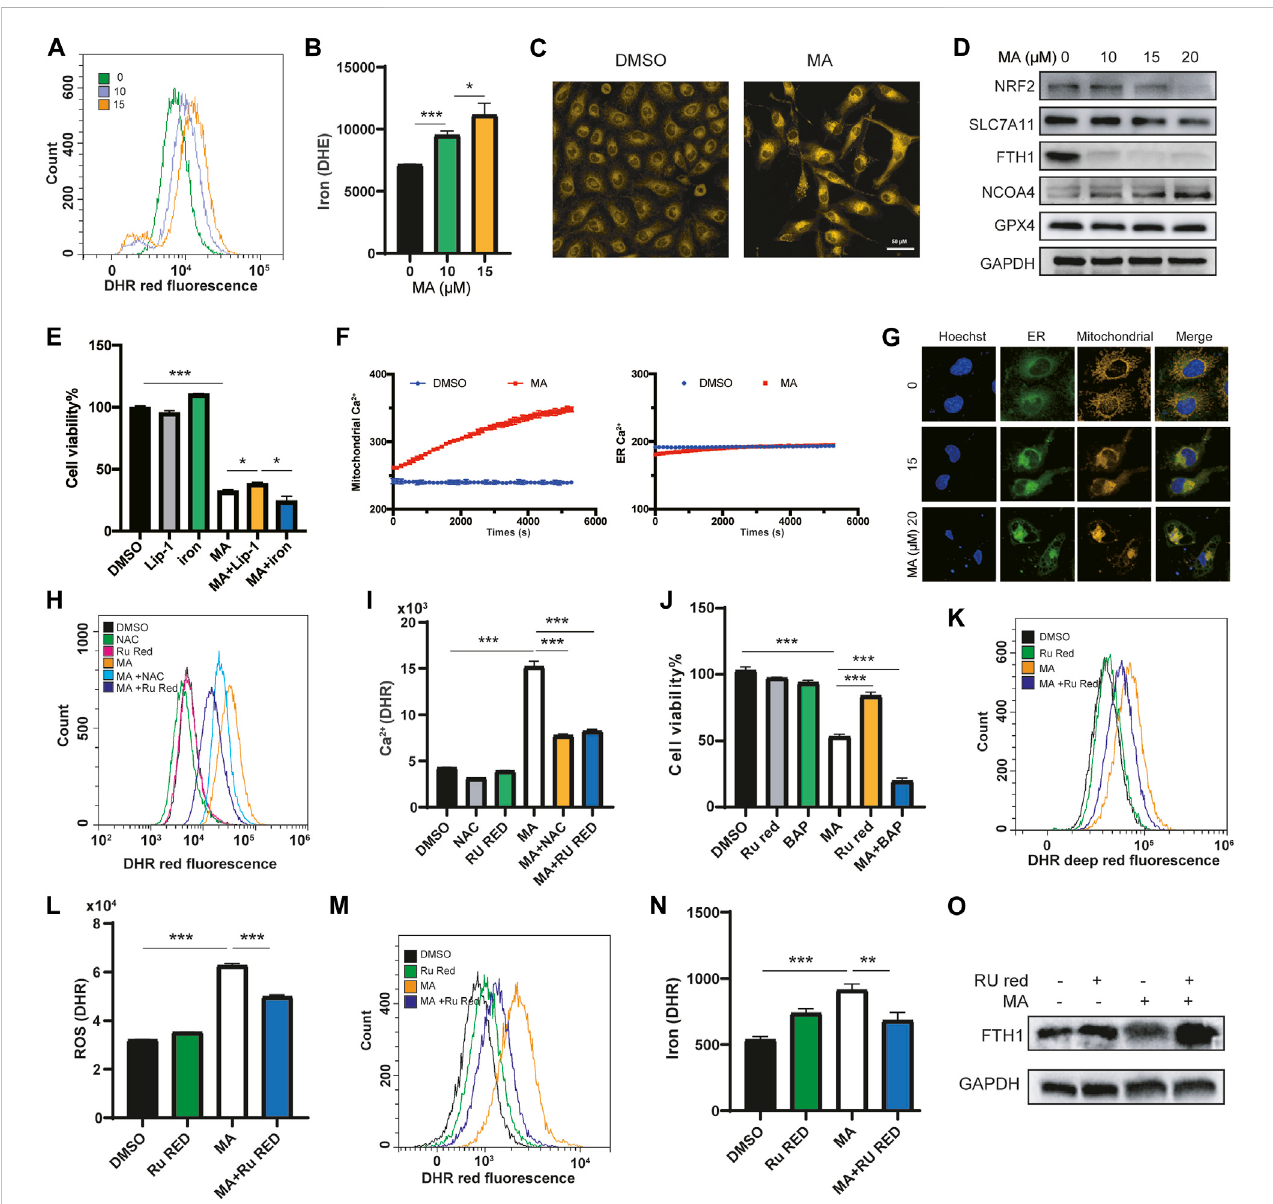
FIGURE 5 MA triggers ferroptosis by inducing mitochondrial Ca 2+ overload in lung cancer cells. Representative fl ow cytometry histogram (A) and quanti fi cation of iron fl uorescence intensity with FerroOrange staining (B) in A549 cells treated with different concentrations of MA. (C) Representative confocal fl uorescence microscopy images of iron staining with ferroOrange (red) in A549 cells treated with MA (15 μ M). (D) Ferroptosis markers were analyzed by western blot in A549 cells treated with different concentrations of MA. (E) Cell viability of A549 cells cotreated with MA (15 μ M) and Lip-1 (1 μ M) or ammonium iron (III) citrate(.1 mg/ml)byCCK-8assays. (F) MitochondrialandERCa 2+ responseincellstreatedwithMA(15 μ M)for1.5 h. (G) Representativeconfocal fl uorescence microscopy images of mitochondrial and ER staining with MitoTracker (red) and ER-Tracker (green) in A549 cells treated with different concentrations of MA. Representative fl ow cytometry histogram (H) and quanti fi cation of mitochondrial Ca 2+ fl uorescence intensity with RhoA staining (I) in A549 cells treated with MA (15 μ M), NAC (1 mM), and Ru Red (1.5 μ M). (J) Cell viability of A549 cells treated with MA (15 μ M), BAP (1 μ M), and Ru Red (1.5 μ M). Representative fl ow cytometry histogram (K) and quanti fi cation of ROS fl uorescence intensity (L) with CellROX staining in A549 cells treated with MA (15 μ M) and RuRed (1.5 μ M). Representative fl ow cytometry histogram (M) and quanti fi cation of iron fl uorescence intensity (N) with FerroOrange staining in A549 cells treated with MA (15 μ M) and Ru Red (1.5 μ M). (O) Ru Red restored the MA-inhibited abundance of FTH1. * p < .05, ** p < .01, *** p <